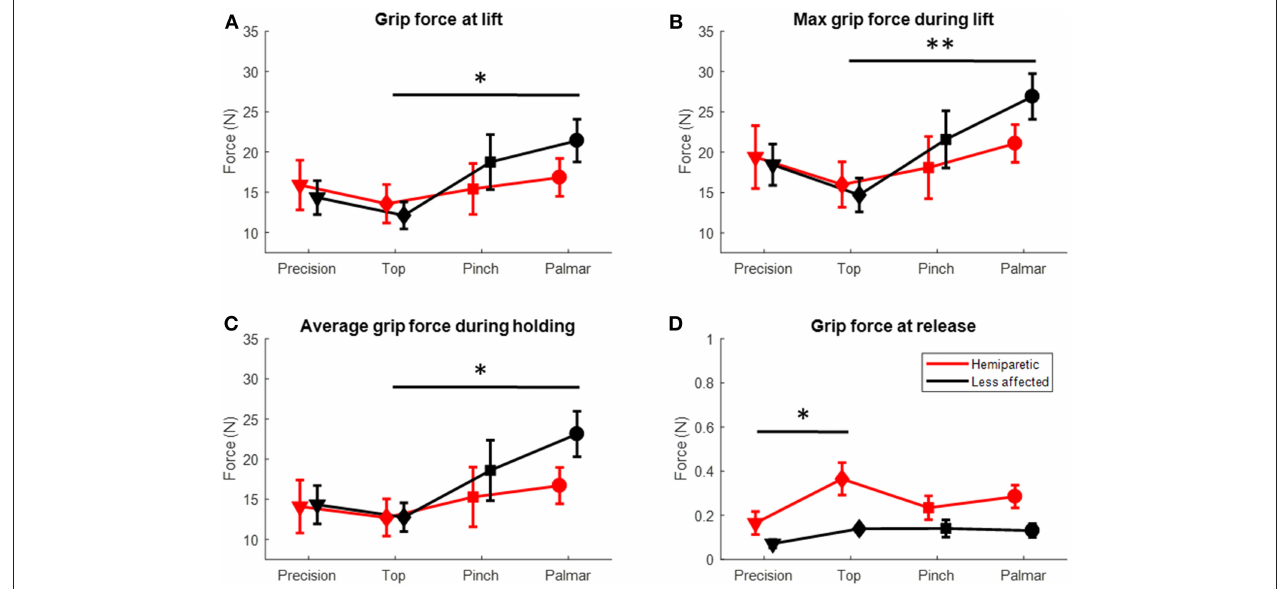
FIGURE 4 | Grip forces for the hemiparetic (red symbols) and less affected arms (black symbols) for the different grasp configurations (in abscissa). (A) Grip force at the time of lifting (tl). (B) Maximum grip force during the lifting phase (C) Average force during the holding phase (D) Grip force at the time of release.*Dunn’s post-hoc p < 0.05; **Dunn’s post-hoc p < 0.01.